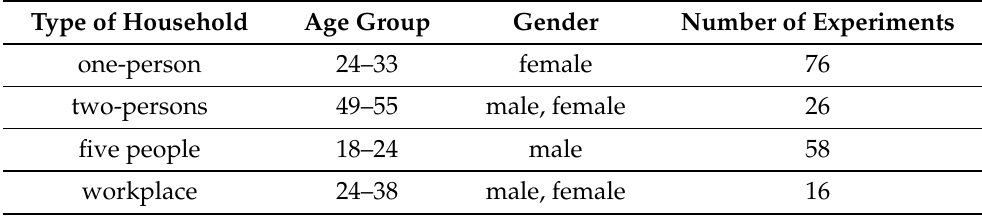
Table 1. Demographic characteristics of the participants of the experiments.